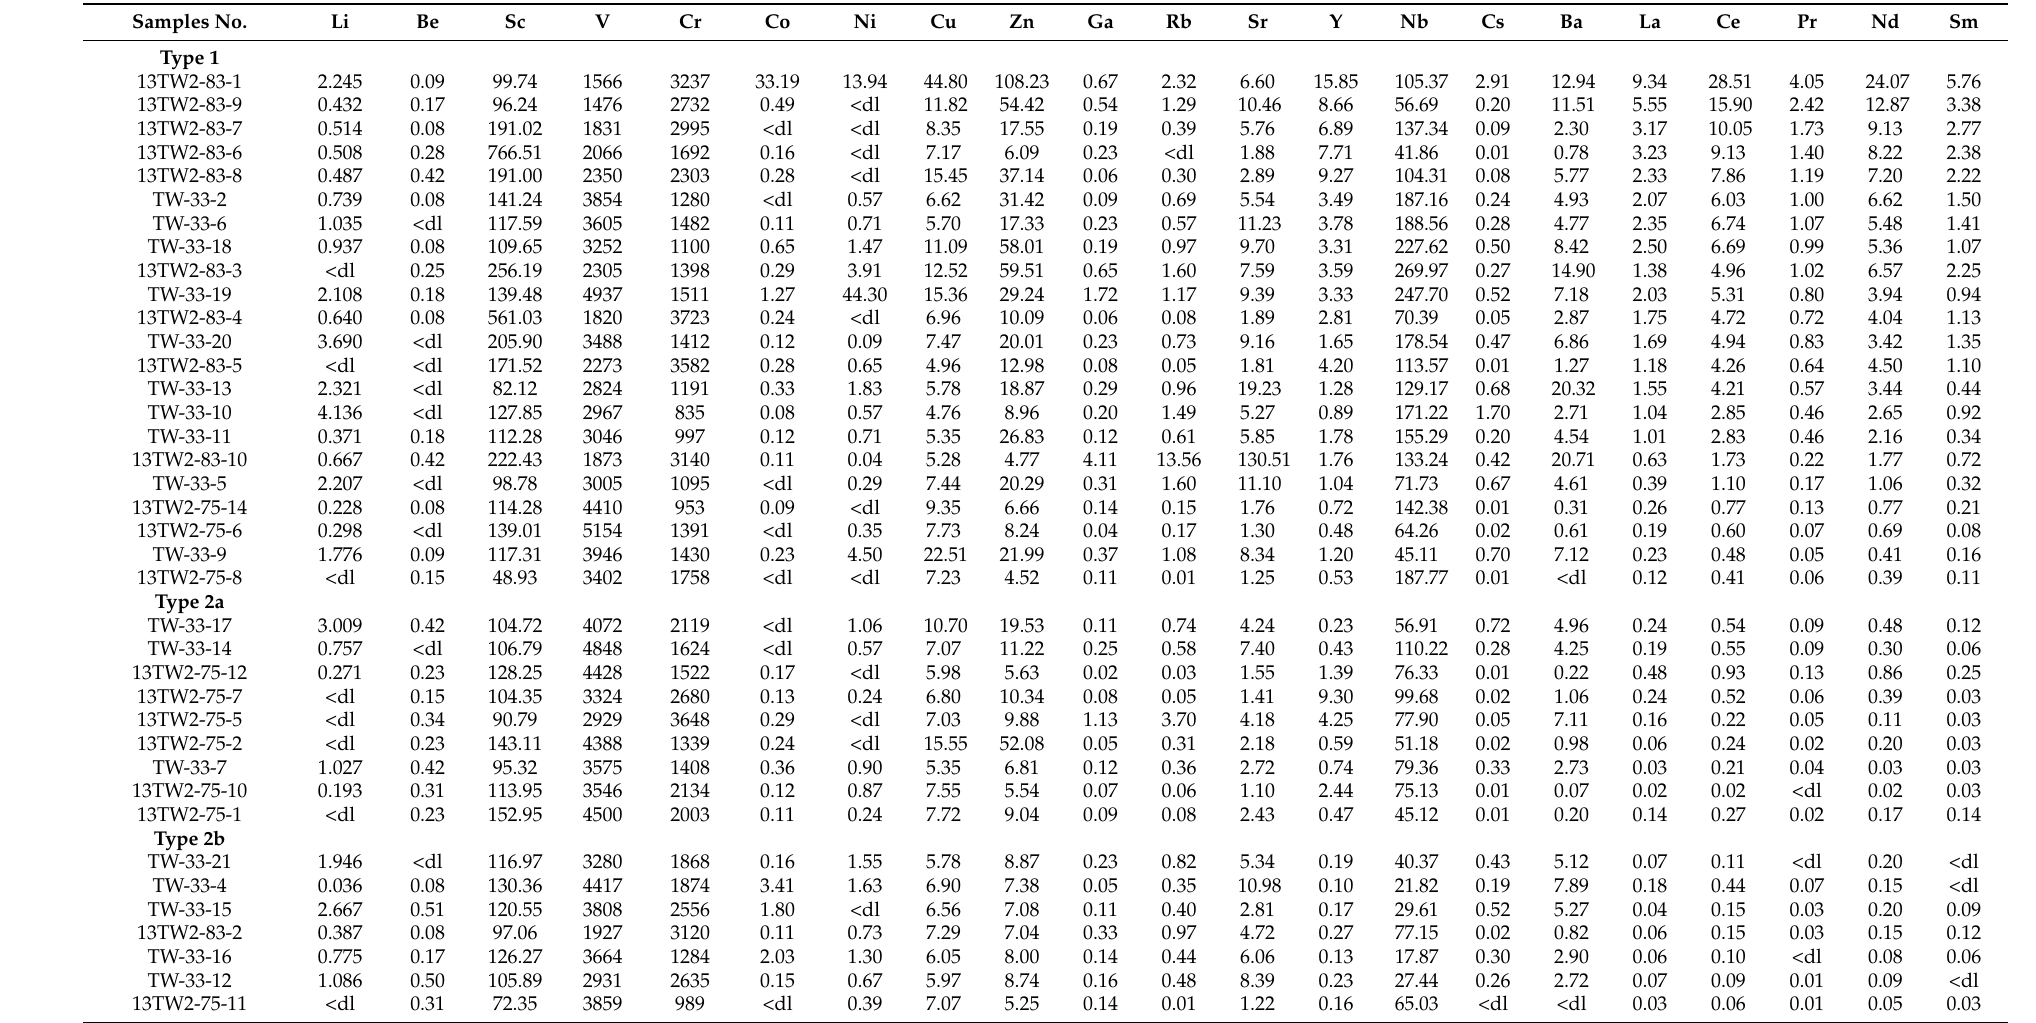
Table 2. LA-ICP-MS trace element analyses of different types of rutile in Tuwu (ppm). dl = detection limits. Samples